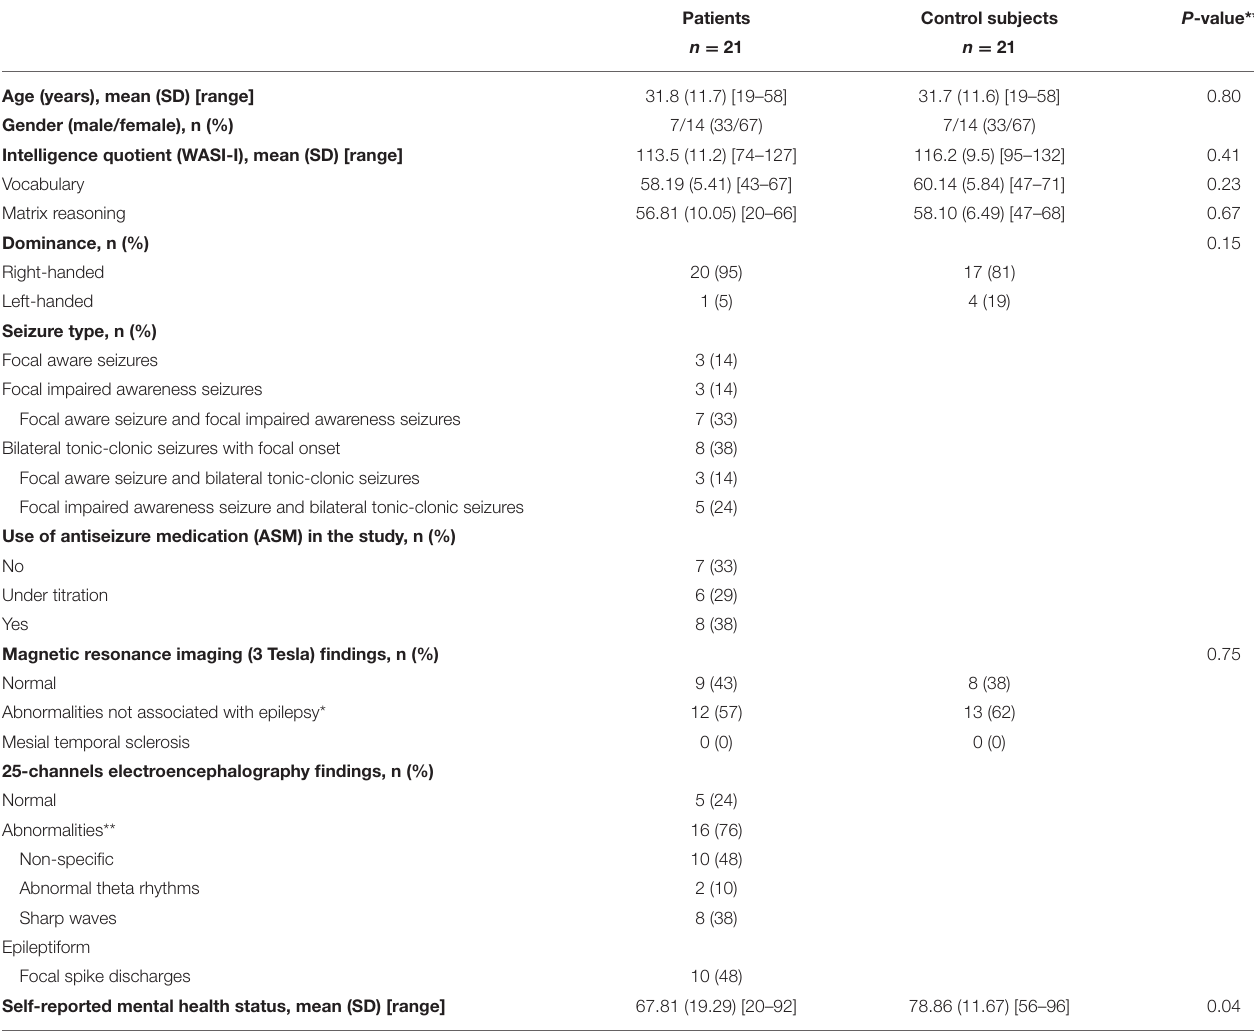
TABLE 1 | Demographical and clinical characteristics of patients with newly diagnosed, nonlesional temporal lobe epilepsy and healthy control subjects. Patients Control